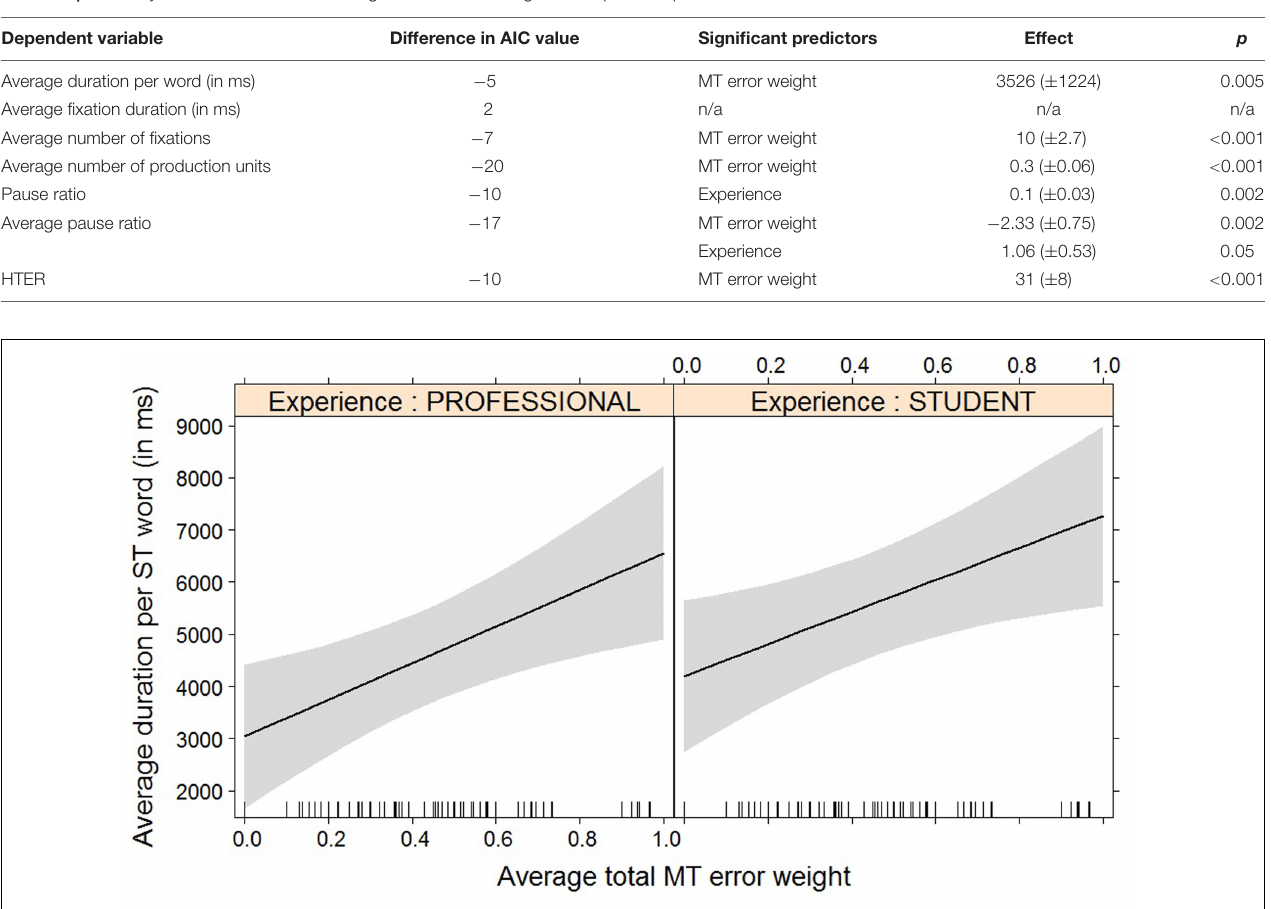
TABLE 2 | Summary of mixed models with average total MT error weight and experience plus interaction effect as fixed